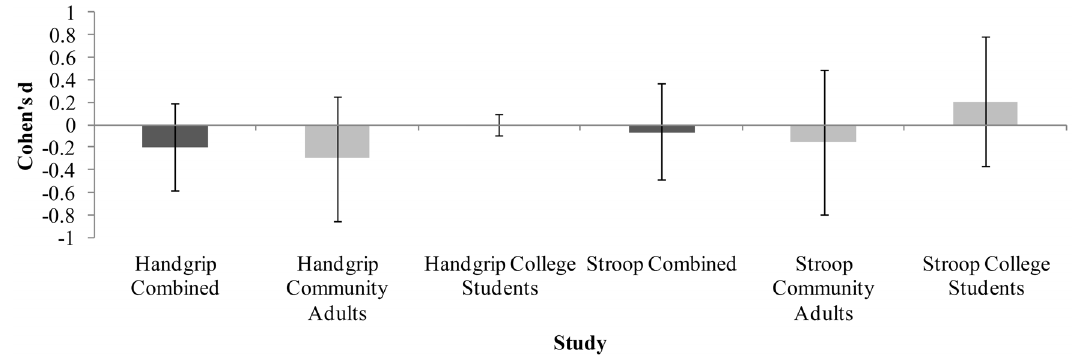
Figure 3. Mean effect sizes (Cohen’s d) for each of the studies and combined samples, along with 95% confidence intervals.